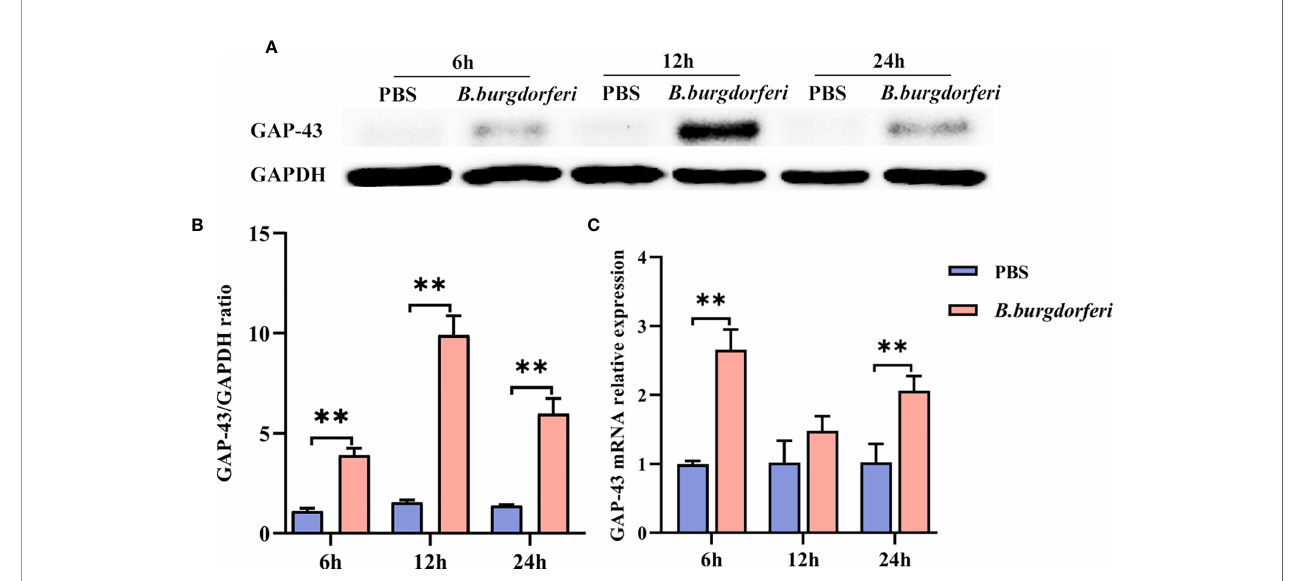
FIGURE 4 | Signi fi cant alteration of GAP-43 mRNA and protein levels after Bb treatment with HMC3. (A) Protein expression of GAP-43 in HMC3 cell lines, co- cultured with live Bb and controls at 6, 12 and 24 h, was veri fi ed by western blotting. (B) Quantitative analysis of GAP-43 protein expression levels. (C) qPCR analysis of GAP-43 expression in HMC3 cell lines, comparing co-cultured with live Bb and controls at 6, 12 and 24 h. ** P < 0.01. Our data were analyzed with two- way ANOVA and expressed as the means ±